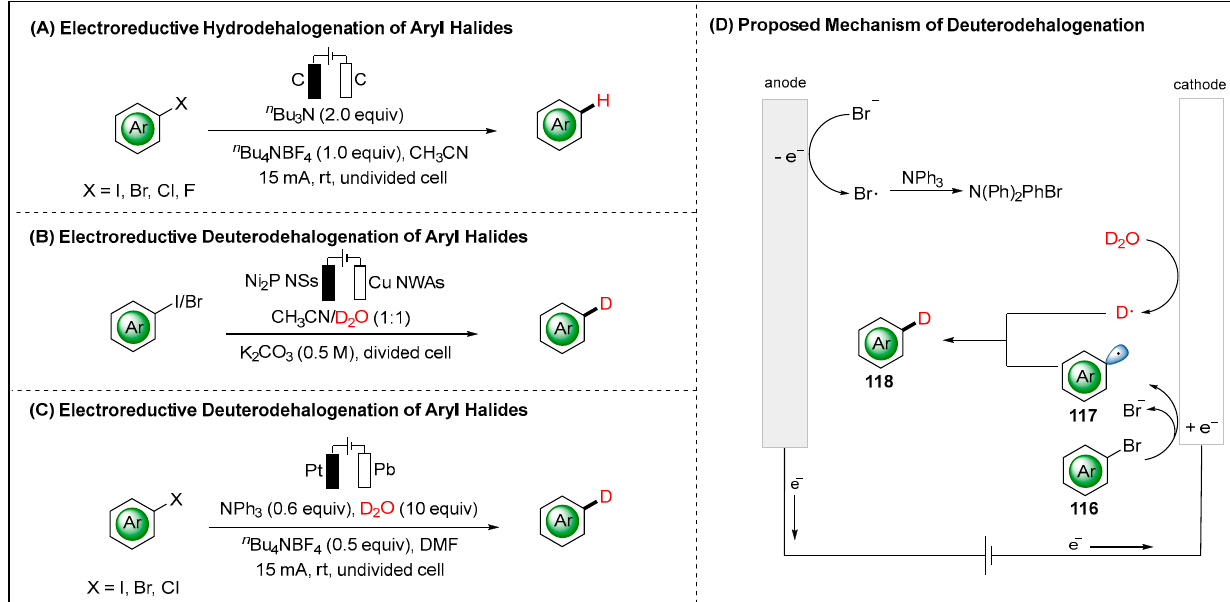
Figure 14. Direct electroreductive hydrodehalogenation and deuterodehalogenation of aryl hal-